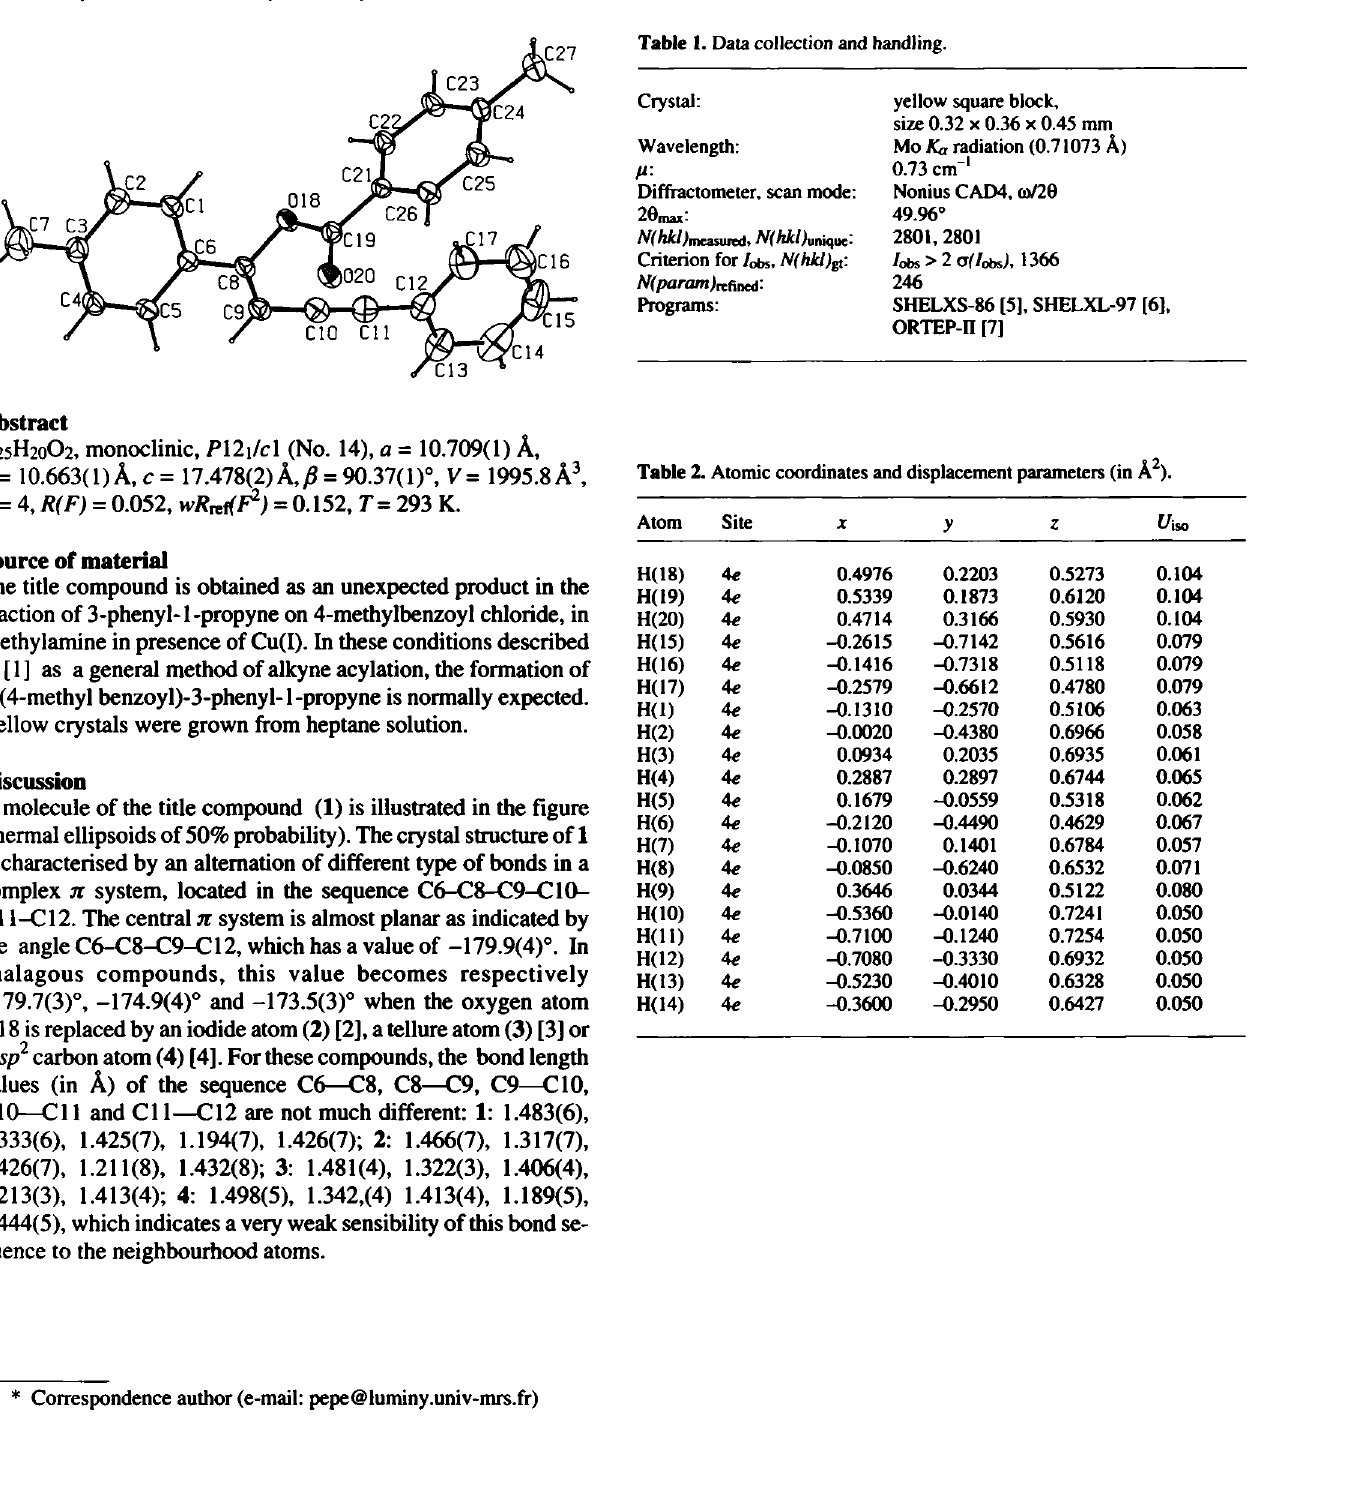
Table 1. Data collection and handling.